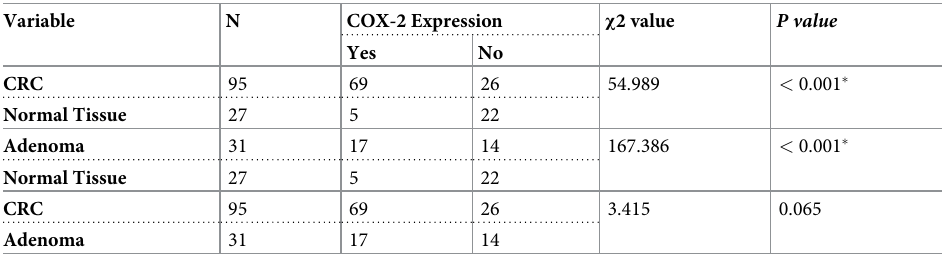
Table 5. Crosstabulation of COX-2expression between CRC and uninvolved resection margin, adenomatous pol- yps and uninvolved resection margin, and CRC and adenomatous polyp.